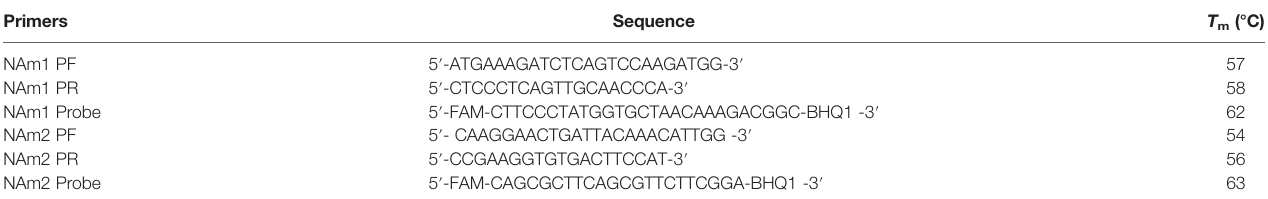
TABLE 1 | The sequences of N anti-mutation (NAm) primers and probes. Primers